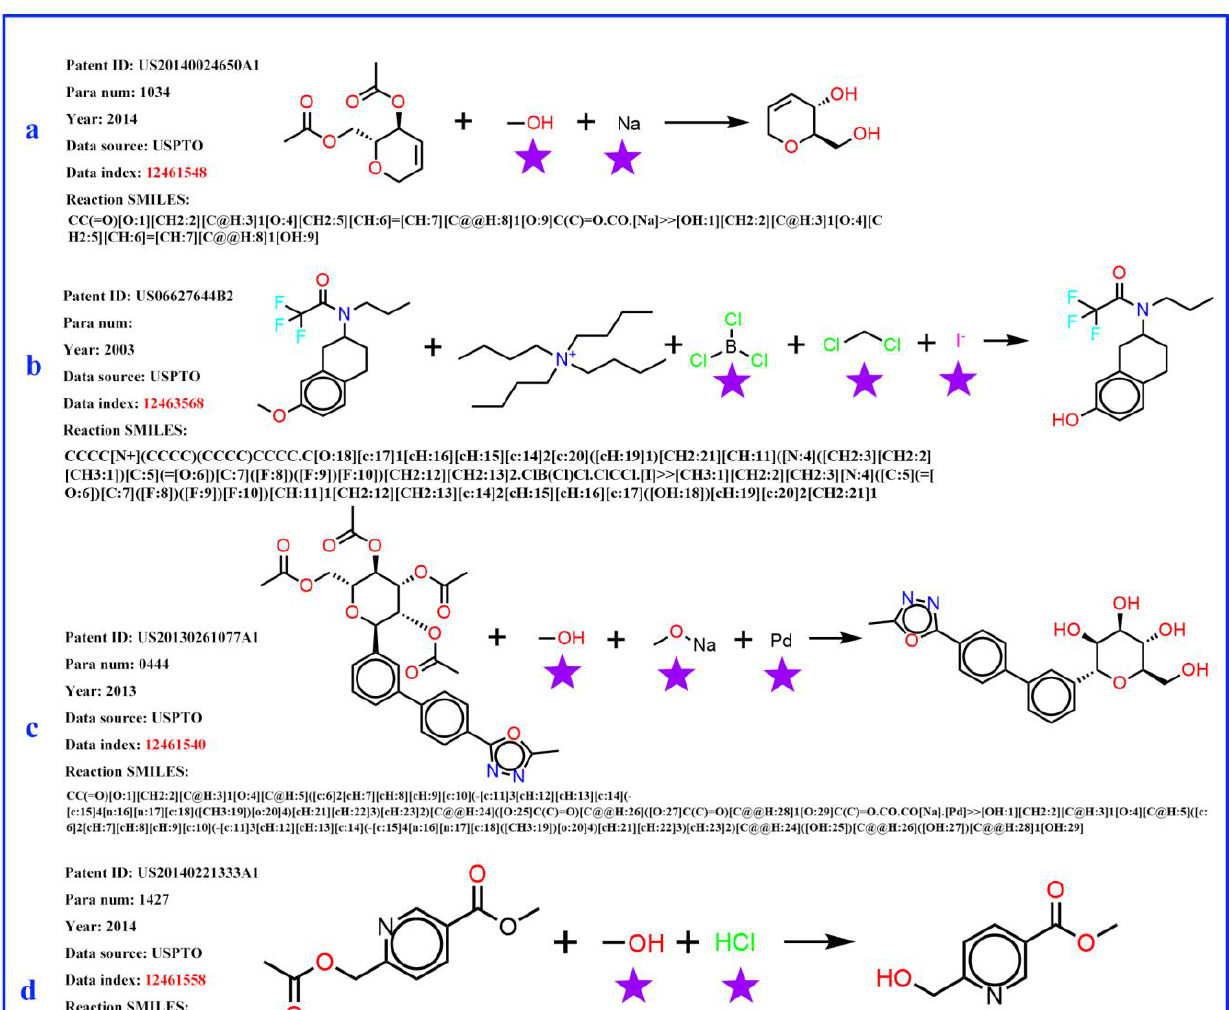
Figure 3. Four examples of original flawed chemical reaction records. The obvious error is marked by a purple pentagram. ( a ) sodium (Na) does not belong to reactants, the methanol serves as a solvent; ( b ) the iodide ion does not belong to this reaction, the methylene dichloride serves as a solvent role; boron tri-chloride and the ammonium ion do not contribute mass to the product and do not belong to the reactant; ( c ) Pd is catalyst, the sodium methanolate serves as a base, and the methyl alcohol is solvent; ( d ) the methyl alcohol is solvent, the HCl provides an acidic environment and is assigned to the reagent